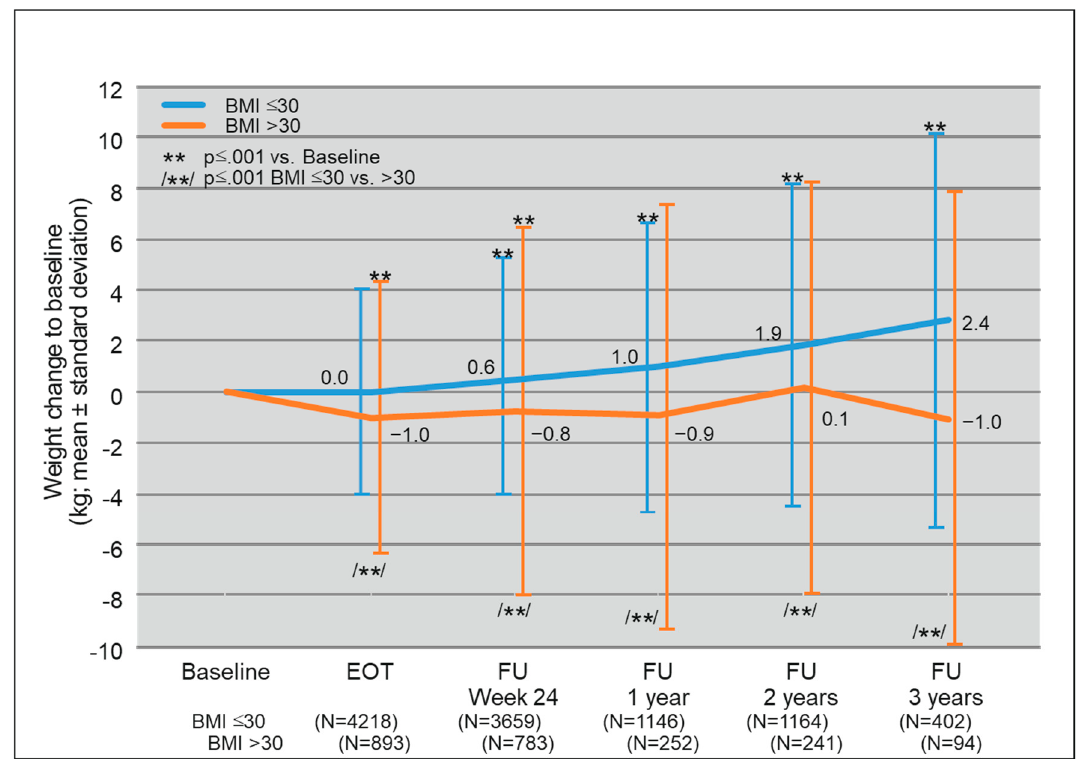
Figure 3. Mean weight change compared to baseline after DAA treatment stratified by obese and non-obese patients. Abbreviations: BMI, body mass index; EOT, end of treatment; FU1, follow up one year after EOT; FU2, follow up two years after EOT; FU3, follow up three years after EOT.